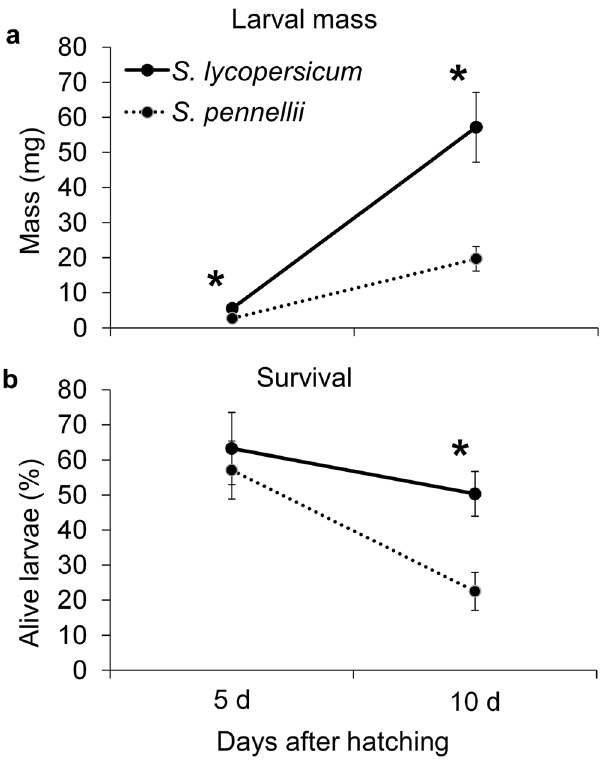
Figure 1. Colorado potato beetle performance on parental tomato plants. ( a ) CPB larval mass and ( b ) survival on S. lycopersicum (solid line) or S. pennellii (dashed line). Values are means ± SE of 7 and 9 plants, respectively. * P < 0.05 by Student’s